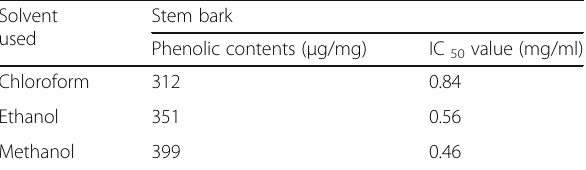
Table 1 Phenolic content and IC50 value in O. ferruginea leaves Solvent used